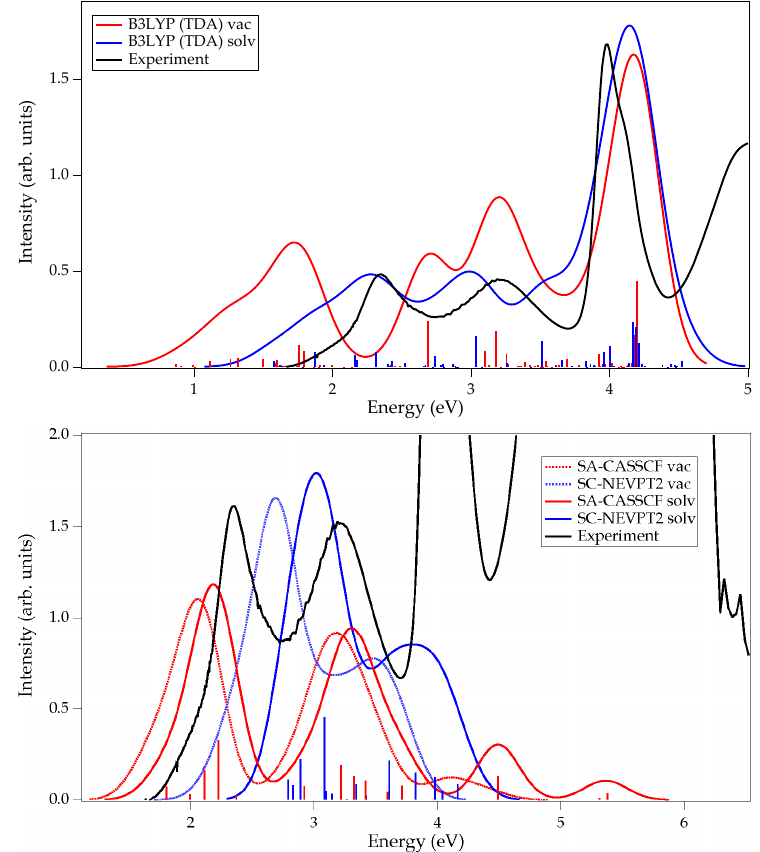
Figure 5. ( top ) Calculated TDA-B3LYP optical absorption spectra in gas phase (red line) and water solution (blue line) of the N3 complex compared with the experimental in water (black line), properly scaled to match the intensity of the first band of the spectrum in solution (blue line); ( bottom ) SA-CASSCF (red) and SC-NEVPT2 (blue) optical absorption spectra in gas phase (dotted lines) and water solution (full lines) of the N3 complex calculated by averaging over 15 states. Comparison with the experimental absorption spectrum is also reported. The spectra were simulated by a Gaussian broadening with σ = 0.17 eV. Vertical sticks correspond to the calculated excitation energies and oscillator strengths. Figure adapted from [59].